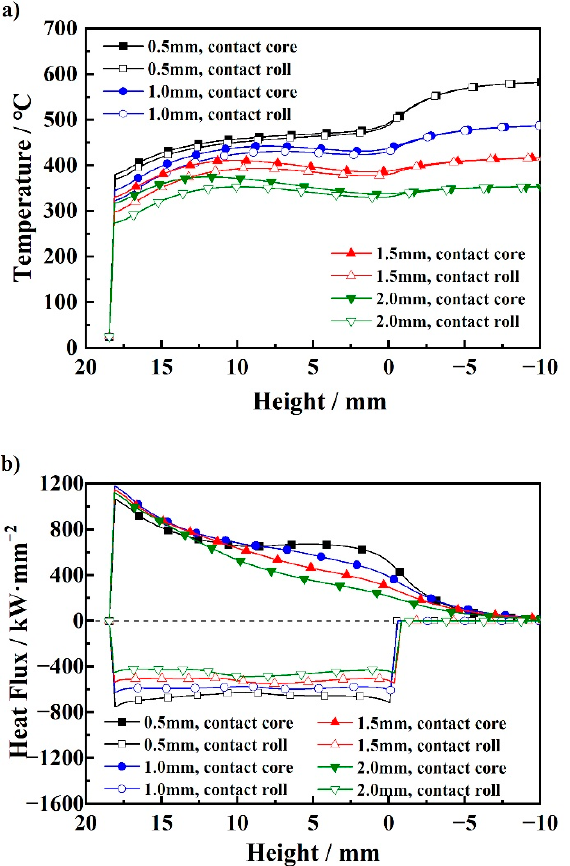
Figure 6. Curves of temperature and heat flux of clad of SLS-TRC with different clad thickness. ( a ) Temperature curves; ( b ) Heat flux curves.